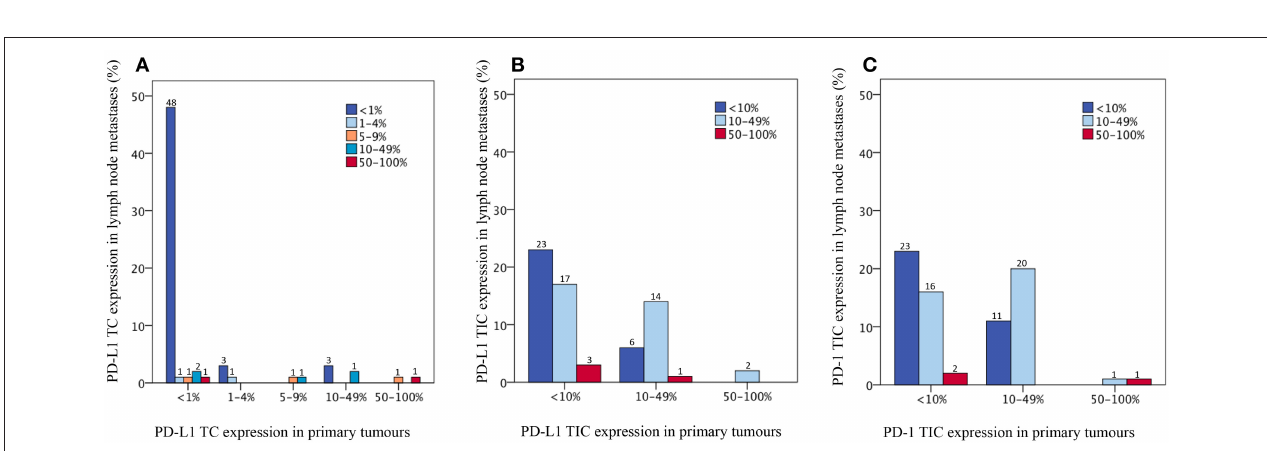
FIGURE 2 | Bar charts visualising the distribution of PD-L1 expression on (A) tumour cells and (B) tumour-infiltrating immune cells and (C) the distribution of PD-1 expression on tumour-infiltrating immune cells, in primary tumours and paired lymph node metastases, in the entire cohort; (A) p = 1.000, (B) p = 0.009, (C) p =